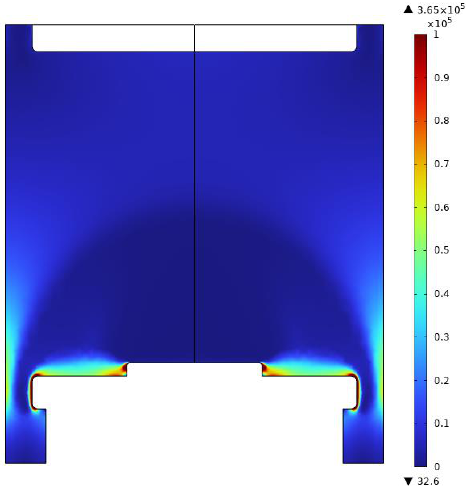
Figure 6. Contour plot of electron field distribution in the deposition chamber (V/m).